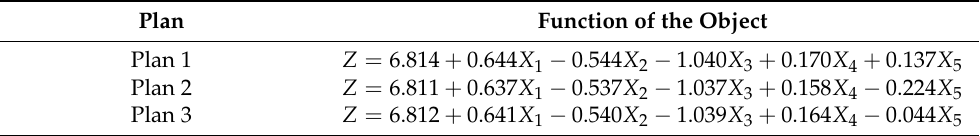
Table 9. The functions of the object obtained for all three plans.